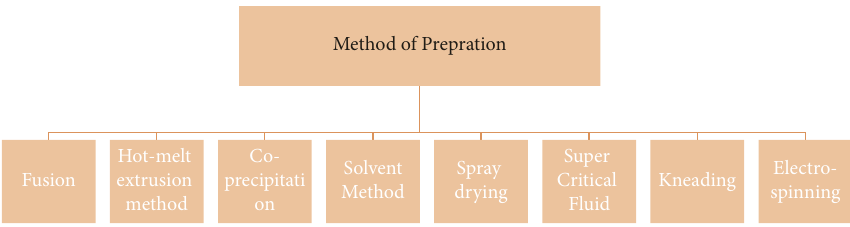
Figure 3: Various methods of solid dispersion preparation